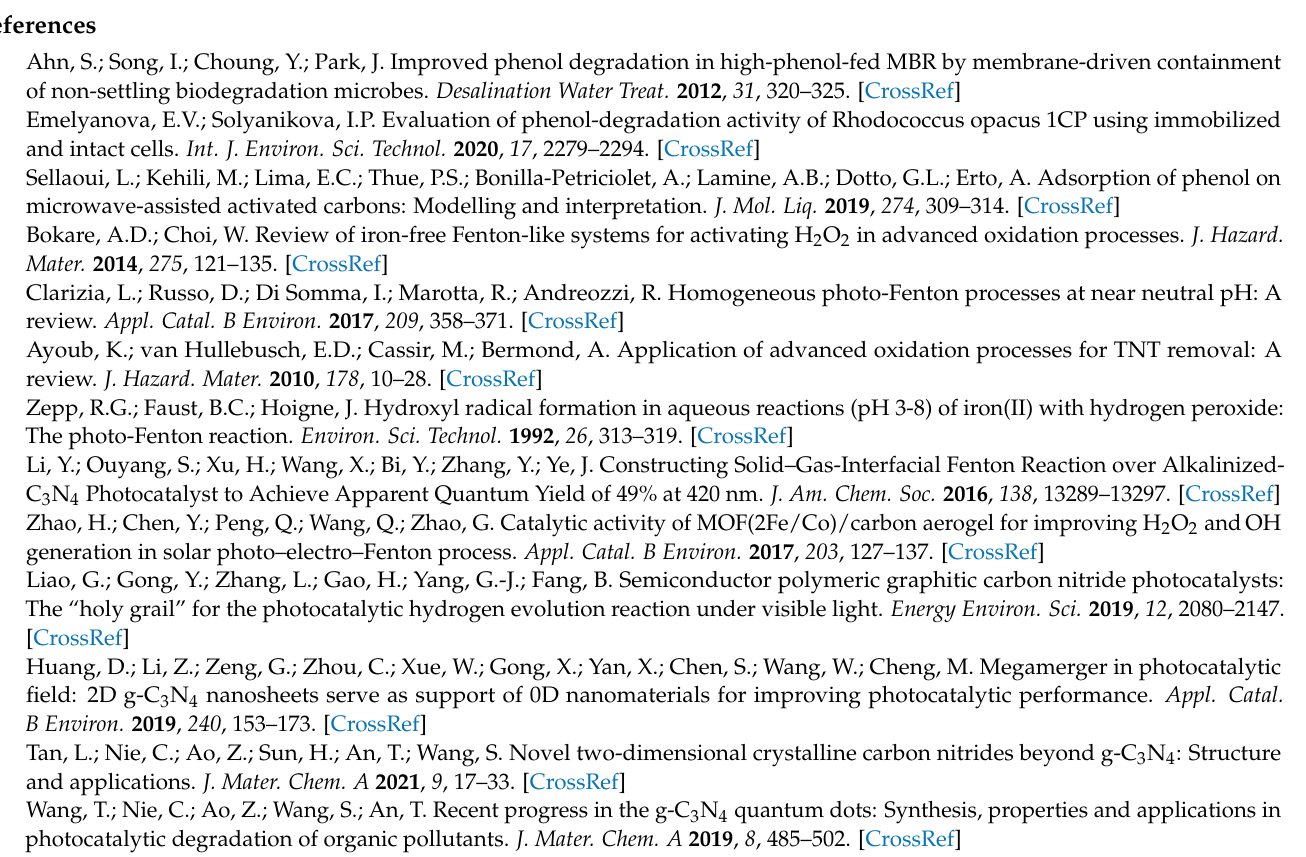
Figure S3. SEM image and the corresponding EDX elemental mapping images of PCN, CNW3 and CNW4. Figure S4. (a,b) TEM and HRTEM images of PCN, (c,d) TEM and HRTEM images of CNW3, (e,f) TEM and HRTEM images of CNW4. Table S1. Comparison of phenol degradation performance under visible